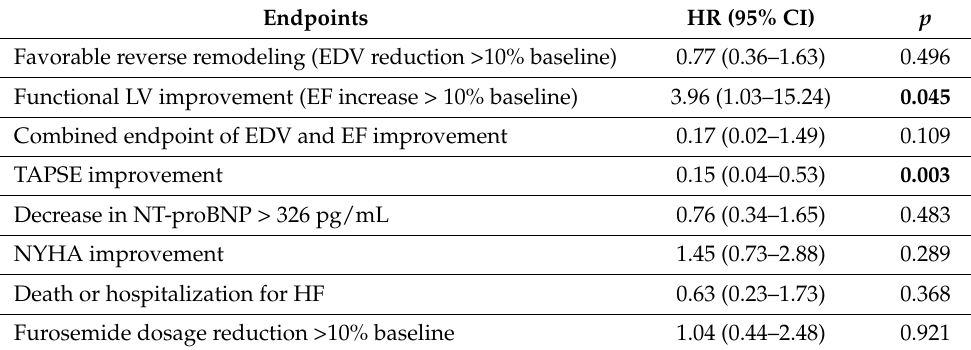
Table 4. Results of Cox regression. Functional LV improvement and TAPSE improvement were signif- icant in non-ischemic group. Combined endpoint of EDV and EF improvement was non-significant but showed a positive trend for non-ischemic group. Reference category for HR computation was the non-ischemic group, apart from the functional LV improvement endpoint, where reference category was the ischemic group. EDV = end diastolic volume, ESV = end systolic volume, EF = ejection fraction, HF = heart failure; LV = left ventricular, NT-proBNP = N-terminal pro-B-type natriuretic peptide, NYHA = New York Hearth Association, TAPSE = tricuspid annular plane systolic excursion. Bold values are statistically